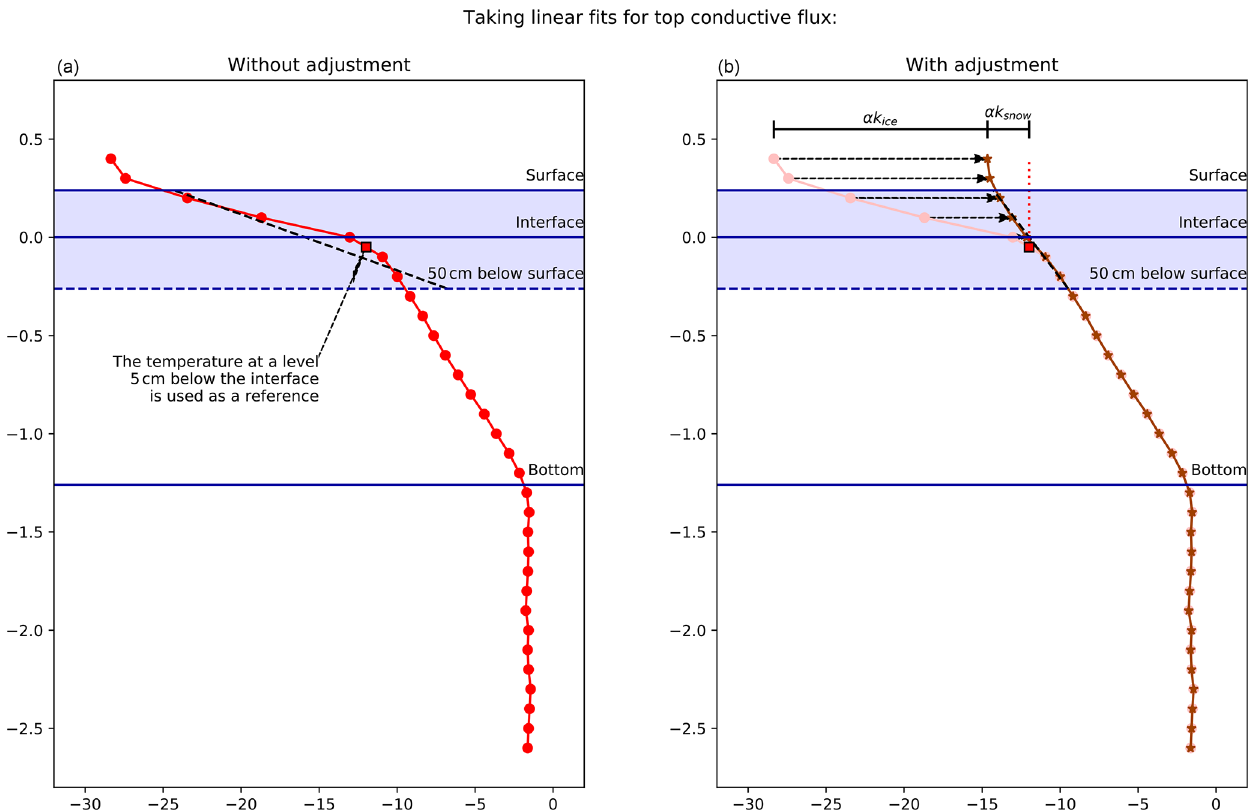
Figure 6. Illustrating the process of estimating conductive flux across the top 50cm of the snow–ice column, in the case that the snow– ice interface lies within this layer. Panel (a) shows the raw temperature profile; taking a linear fit through these points does not produce a meaningful result because of the sharp “corner” associated with the change in medium. Panel (b) shows the adjusted temperature profile; the temperatures that would be expected if the snow layer were ice, temperature below the interface and conductive fluxes remaining the same. The adjusted profile eliminates the corner, and a linear fit can be taken. In panel (b) , k ice denotes ice conductivity, k snow snow conductivity and α an arbitrary constant of